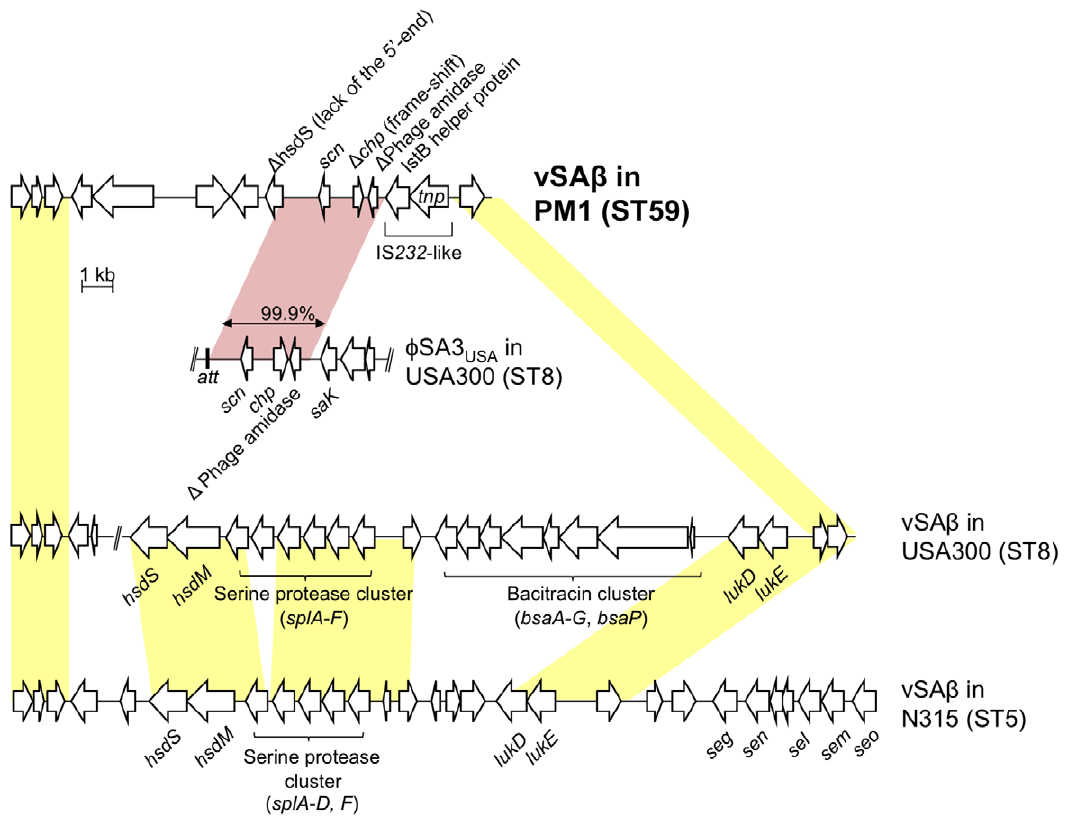
Figure 5. Structure of n SA b in PM1. The 15,551-bp n SA b structure in PM1 is shown in the upper part. This sequence was compared to the data of ST8 CA-MRSA strain USA300 FPR3757 (GenBank accession number NC_007793) and ST5 HA-MRSA strain N315 (GenBank accession number BA000018). PM1 regions homologous to w SA3 USA (of USA300) and n SA b s (of USA300 and N315) are shaded in pink and yellow, respectively. A Greek delta symbol indicates truncated coding